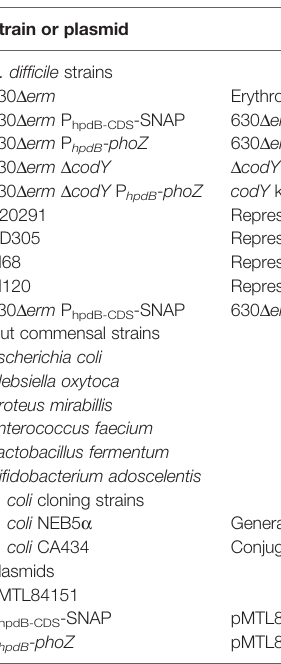
TABLE 1 | Strains and plasmids used in this